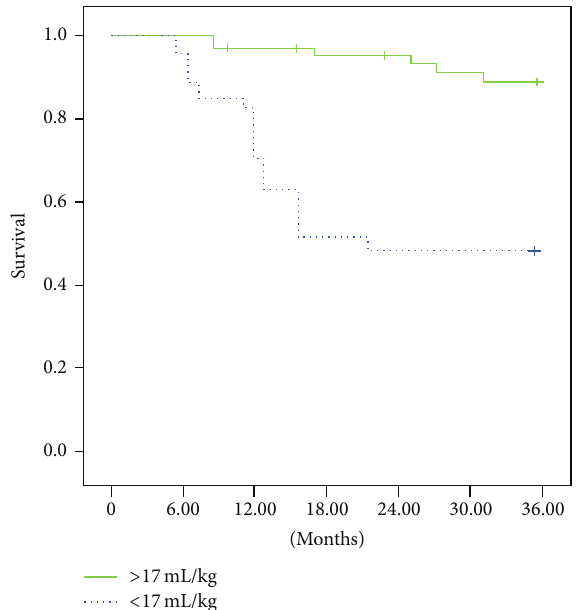
Figure 3: Patients with VO 2 peak values below 17 mL/kg had a survival rate of 55% compared with a rate of 94% for patients with VO 2 peak values above 17 mL/kg ( 𝑝 = 0.0001 ); relative risk = 4.10 (2.1– 6.12, 95% CI).